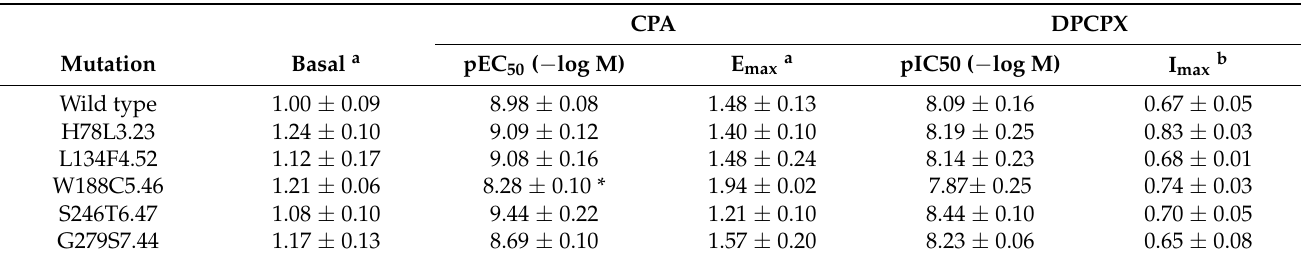
Figure 5. [ 35 S]GTP γ S binding to the transiently transfected wild type hA 1 AR, LFM L134F 4.52 , CIMs W188C 5.46 and G279S 7.44 , and CAMs H78L 3.23 and S246T 6.47 on CHO cell membranes. ( A ) Receptor activation of wild type and mutant hA 1 ARs stimulated by CPA. Data were normalized as ratio over basal activity of wild type hA 1 AR. ( B ) Concentration–inhibition curves of DPCPX with the presence of CPA at the concentration of EC 80 for wild type and mutant hA 1 AR. Data were normalized as ratio over basal activity of wild type or mutant hA 1 AR. Data were obtained from three different experiments, each performed in duplicate. Data for CIMs are shown in red, for CAMs in green, and for LFMs in grey. Table 4. Potency and efficacy values of CPA and DPCPX in [ 35 S]GTP γ S binding assays on wild type and mutant hA 1